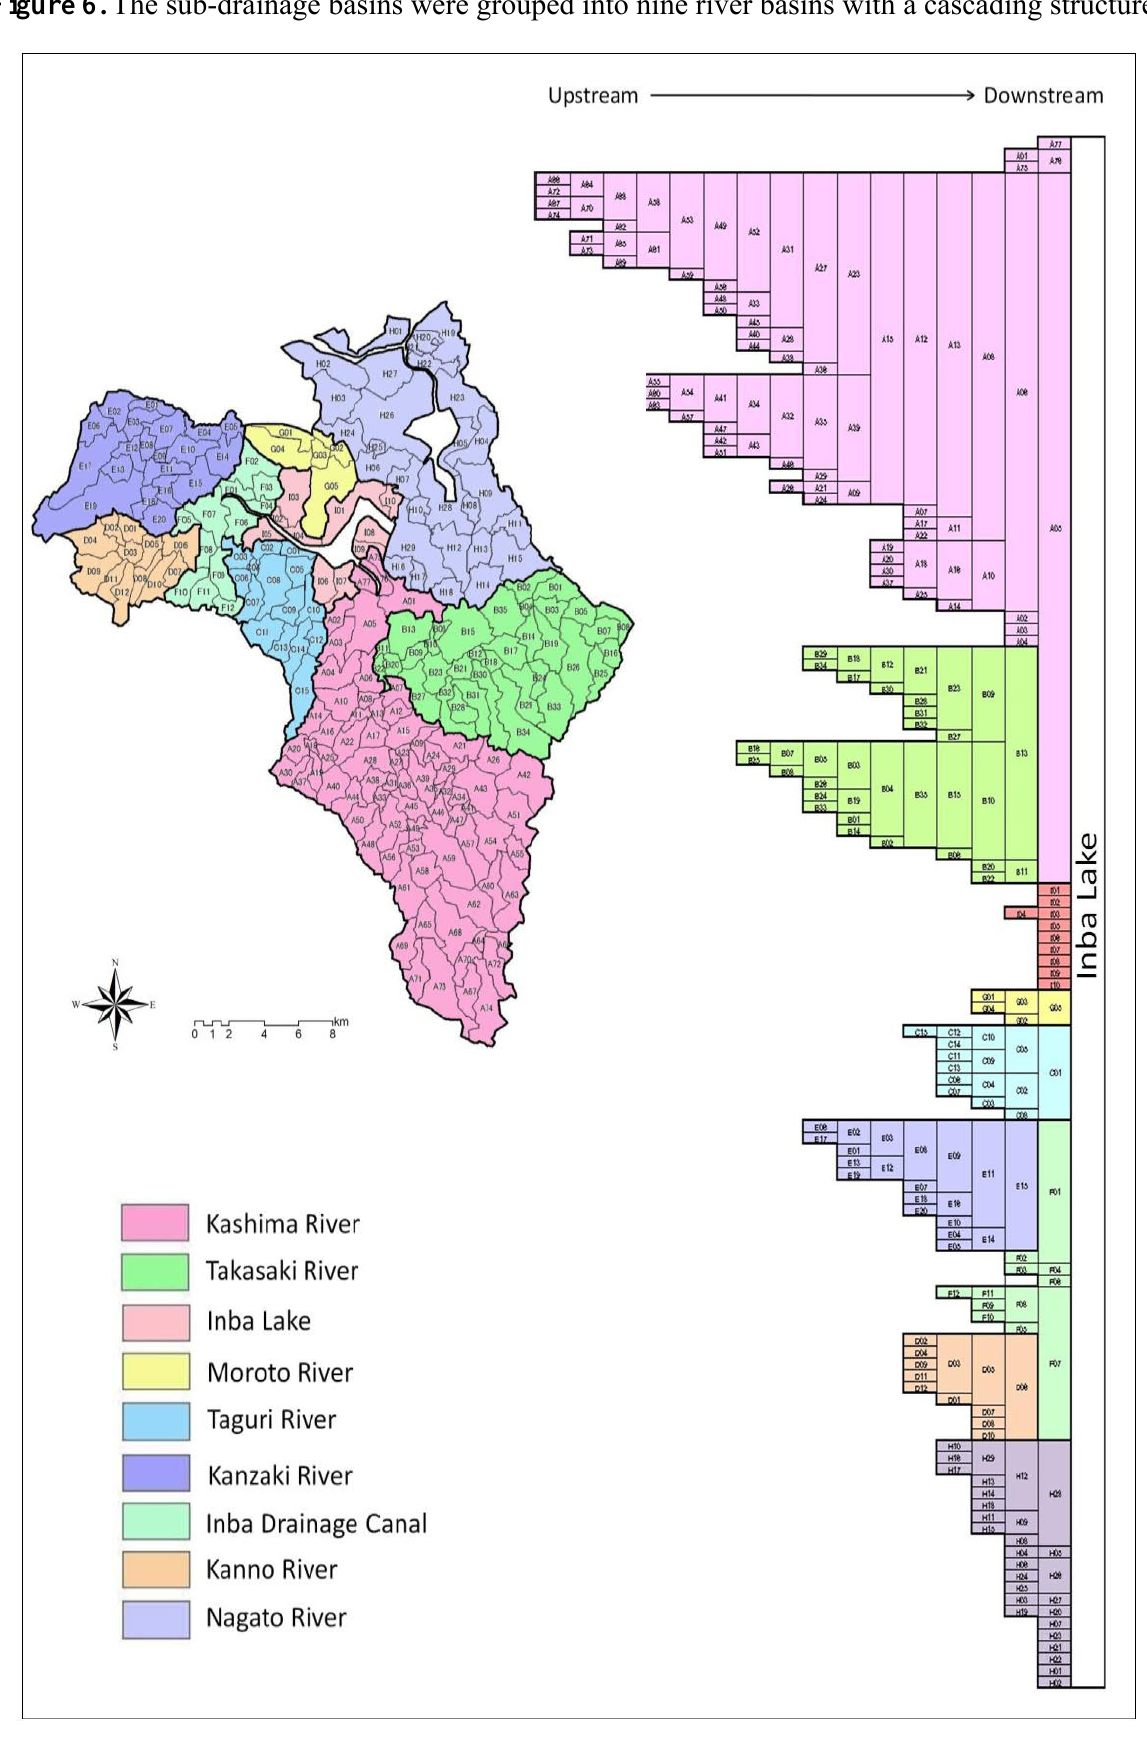
Figure 6. The sub-drainage basins were grouped into nine river basins with a cascading